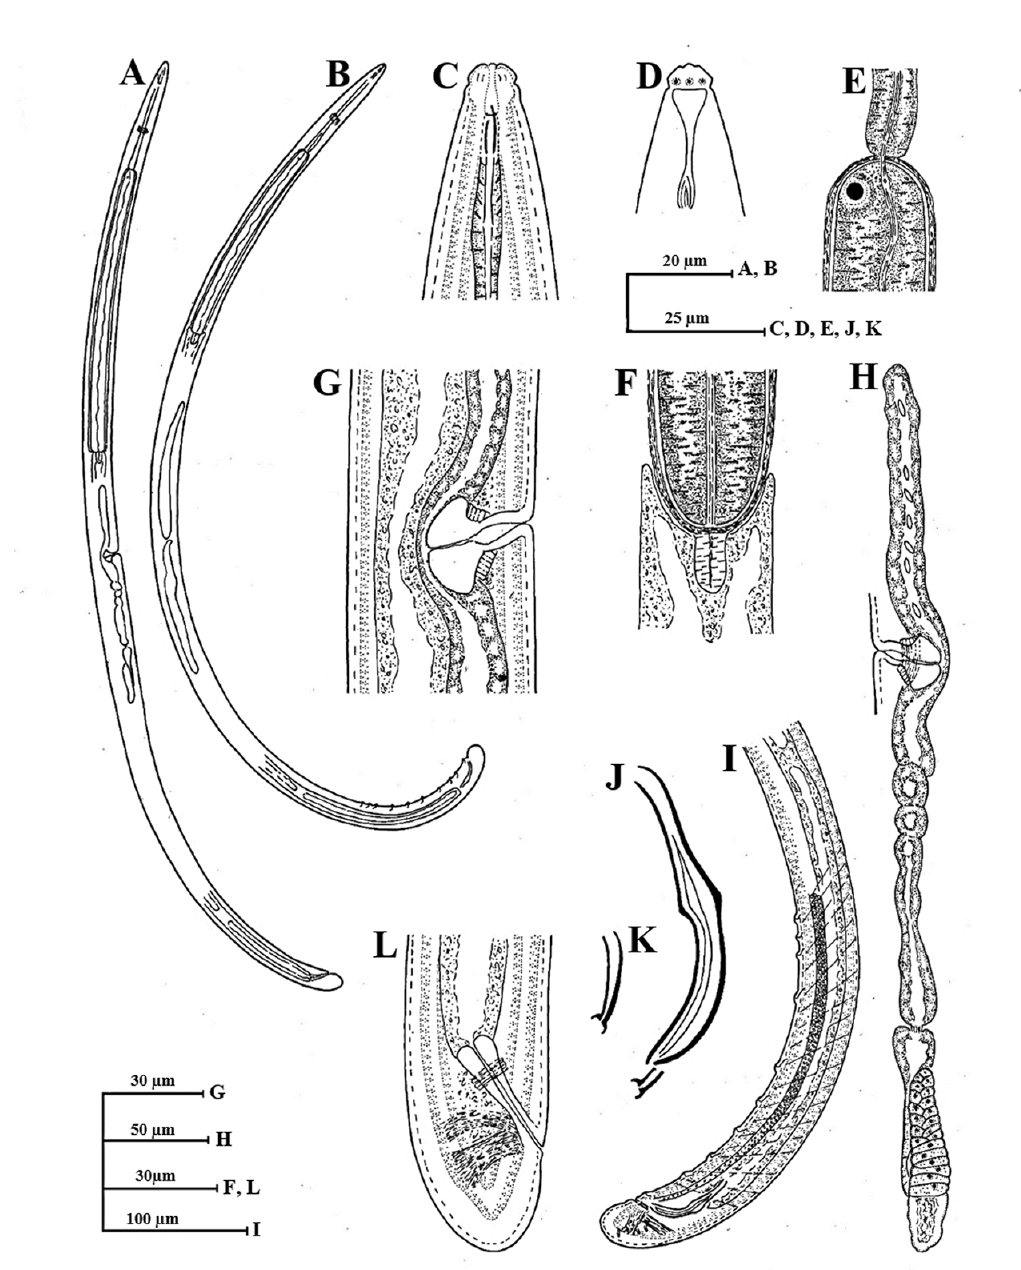
Fig. 15. Axonchium uniqum sp. nov. A , C – D , G , L . Holotype, ♀ (AMU/ZD/ Axonchium uniqum sp. nov. /1). B , I – K . Paratype 3, ♂ (slide 3). E – F , H . Paratype 2, ♀ (slide 3). A . Entire female. B . Entire male. C . Anterior region. D . Anterior end showing amphid. E . Junction between anterior and posterior expanded part of pharynx. F . Cardia. G . Vulva. H . Female genital system. I . Male posterior end. J . Spicule. K . Lateral guiding piece. L . Female